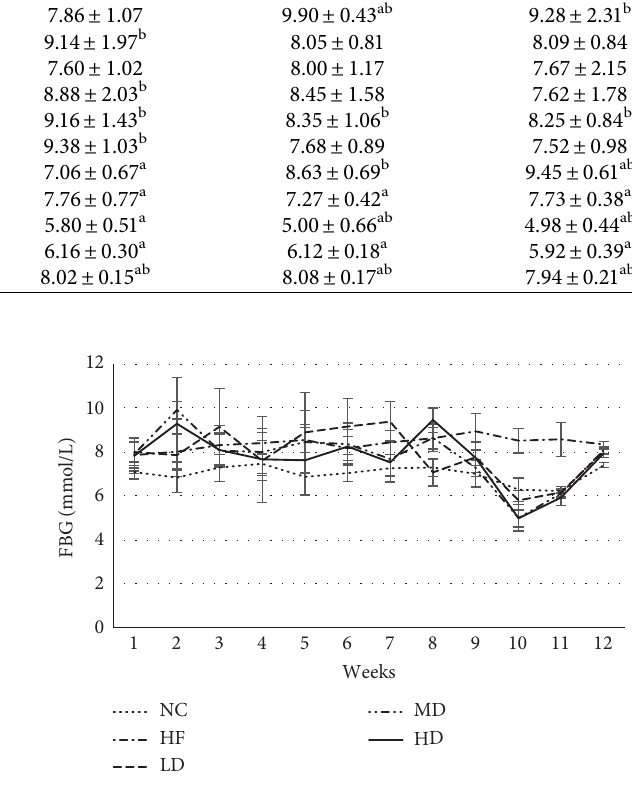
Figure 4: Mean value of FBG measured weekly of mice in each group (means ± SD, mmol/L). The mean value of FBG in the MD group and HD group was lower than 5 mmol/L at the 10 th